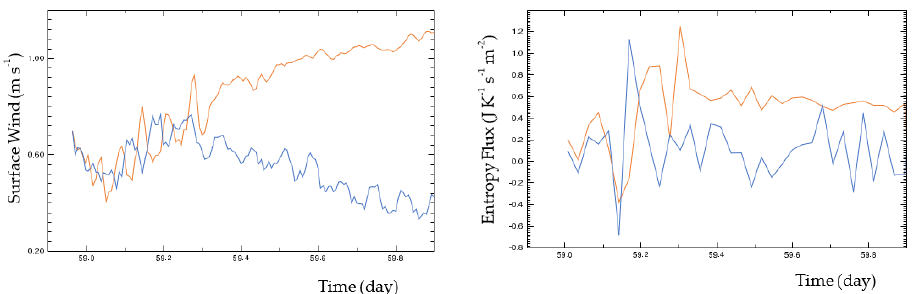
Figure 13. Modeled time series of ( left ) the horizontally averaged surface wind speed and ( right ) the entropy flux at z = 0.75 km in the (red) test and (blue line) reference columns. sponds to the peak of red line at z = 2 km in Figure 14. Since ∆𝑠 2𝑘𝑚∗ is a function of Δ T 2 km , In the modeled two-day oscillation, the surface wind gusts induced by convective